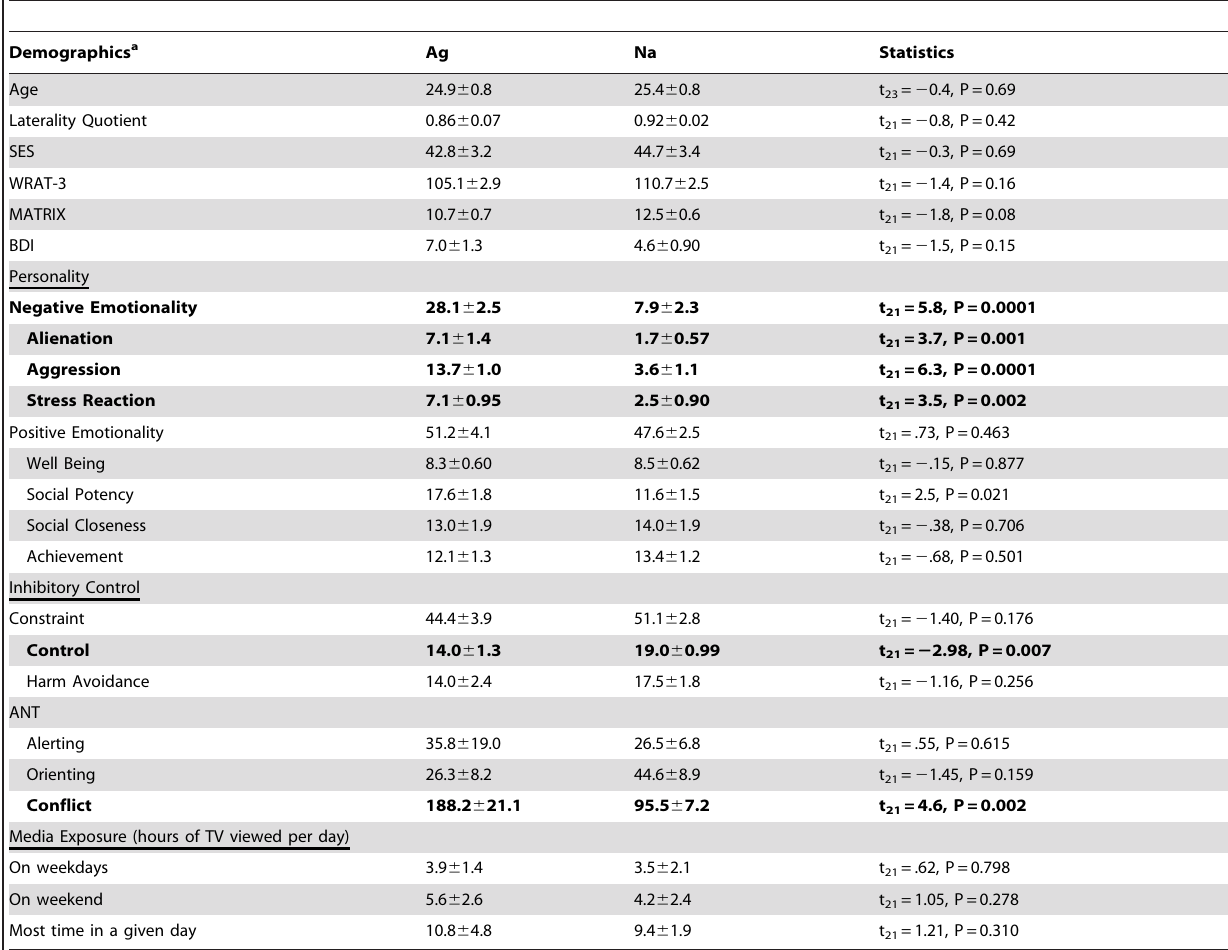
Table 1. Demographics, personality, inhibitory control, and media exposure as a function of trait